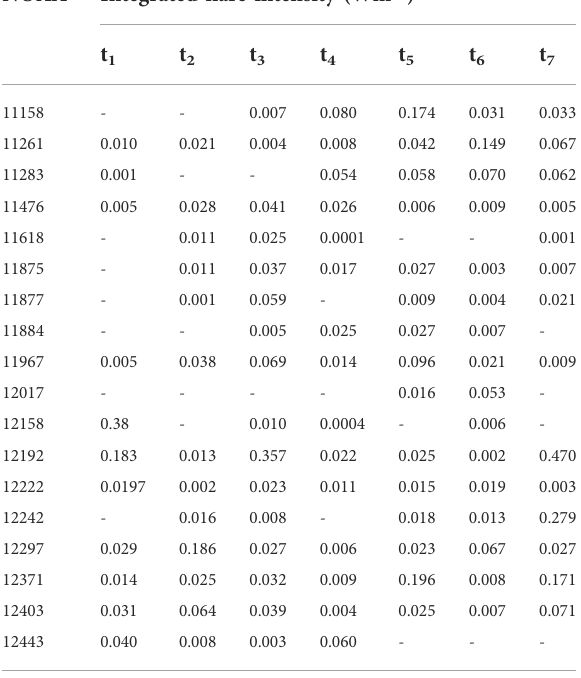
TABLE 2 Integrated intensity of all the fl ares produced by the active regions (see Table 1) on each day of